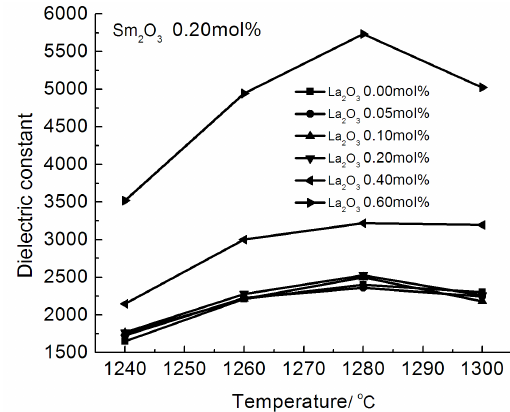
Fig. 5 The relationship curves between the dielectric constant and the sintering temperature with Sm